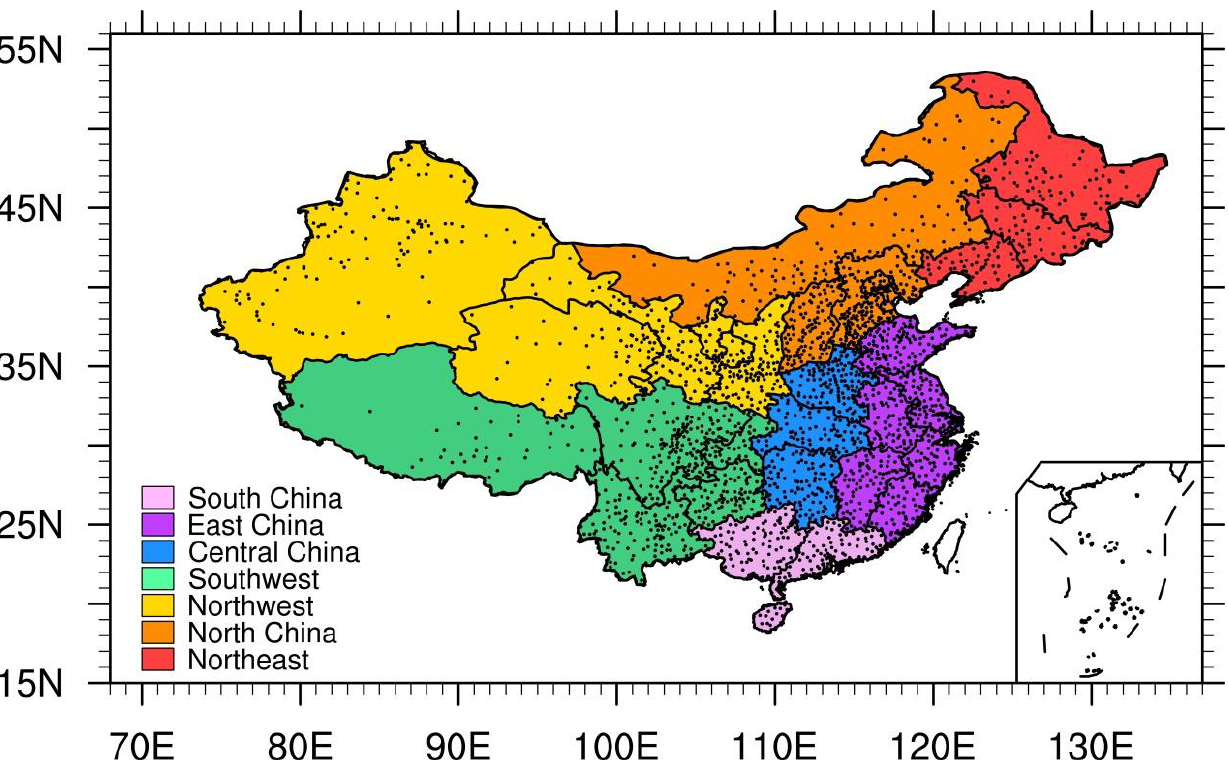
Figure 1. Distribution of national-level surface weather stations in